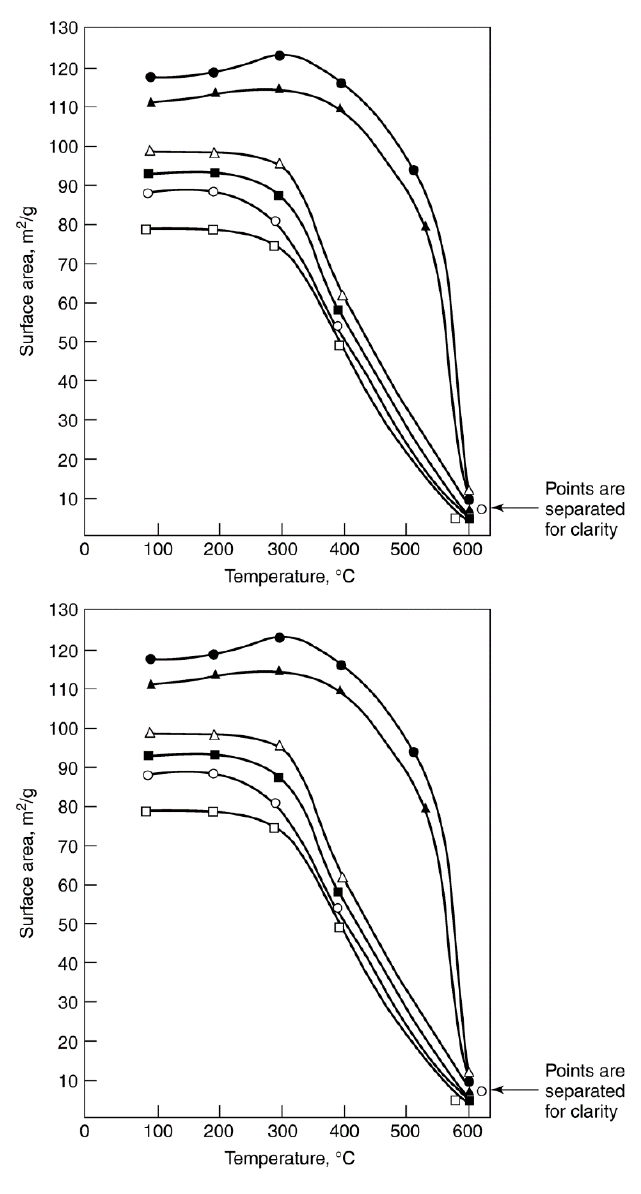
Figure 19. BET surface area of titania as a function of thermal treatment and chlorine content of fresh samples (before pretreatment). Samples were treated at the temperature indicated for 2 h. Reproduced from [117]. Copyright 1985, Elsevier. ● = Blank TiO 2 ; ▲ =TiO 2 soaked in H 2 O; Δ = TiO 2 soaked in HCl/H 2 O (2.06 wt% Cl); ■ = TiO 2 soaked in HCl/H 2 O (2.40 wt% Cl);○ = TiO 2 soaked in HCl/H 2 O (2.55 wt% Cl); □ = TiO 2 soaked in HCl/H 2 O (2.30 wt%